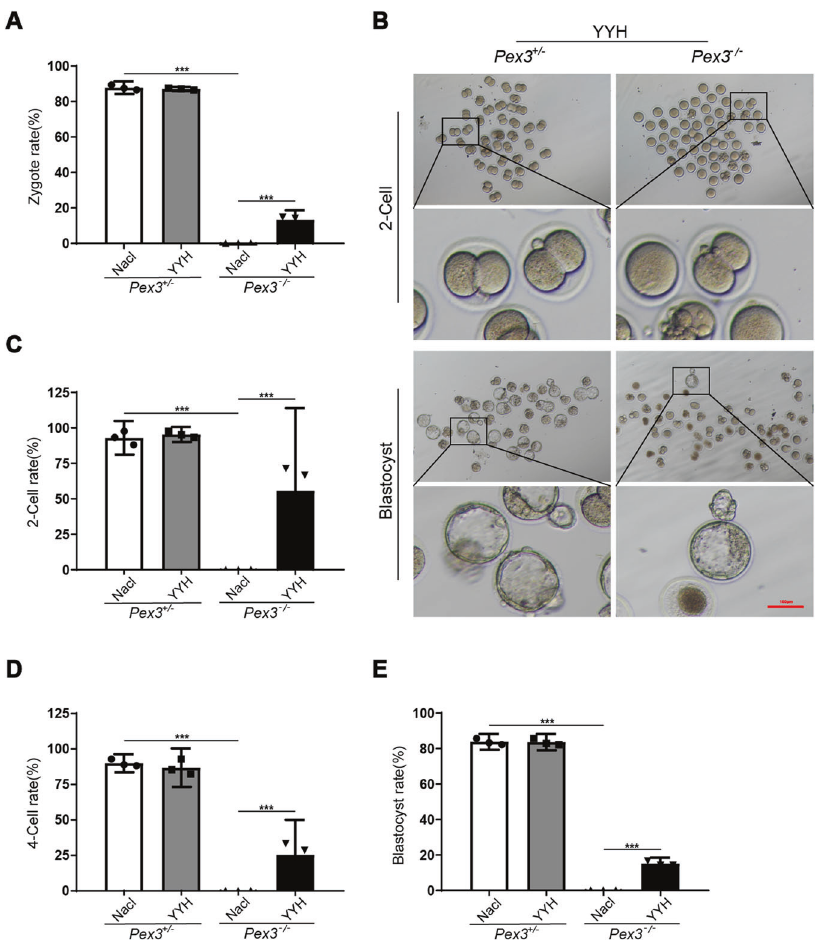
Fig. 3 Effects of Epimedium granule supplementation on fertility outcomes and early embryonic development of Pex3 -KO mice ( n = 3). A Fertilization rate. B Representative contrast images of the Pex3 + / − and Pex3 − / − groups in the IVF experiment and blastocyst embryos in male mice after YYH administration. Scale bars: 100 μ m. C Two-cell embryo rate. D Four-cell embryo rate. E Blastocyst